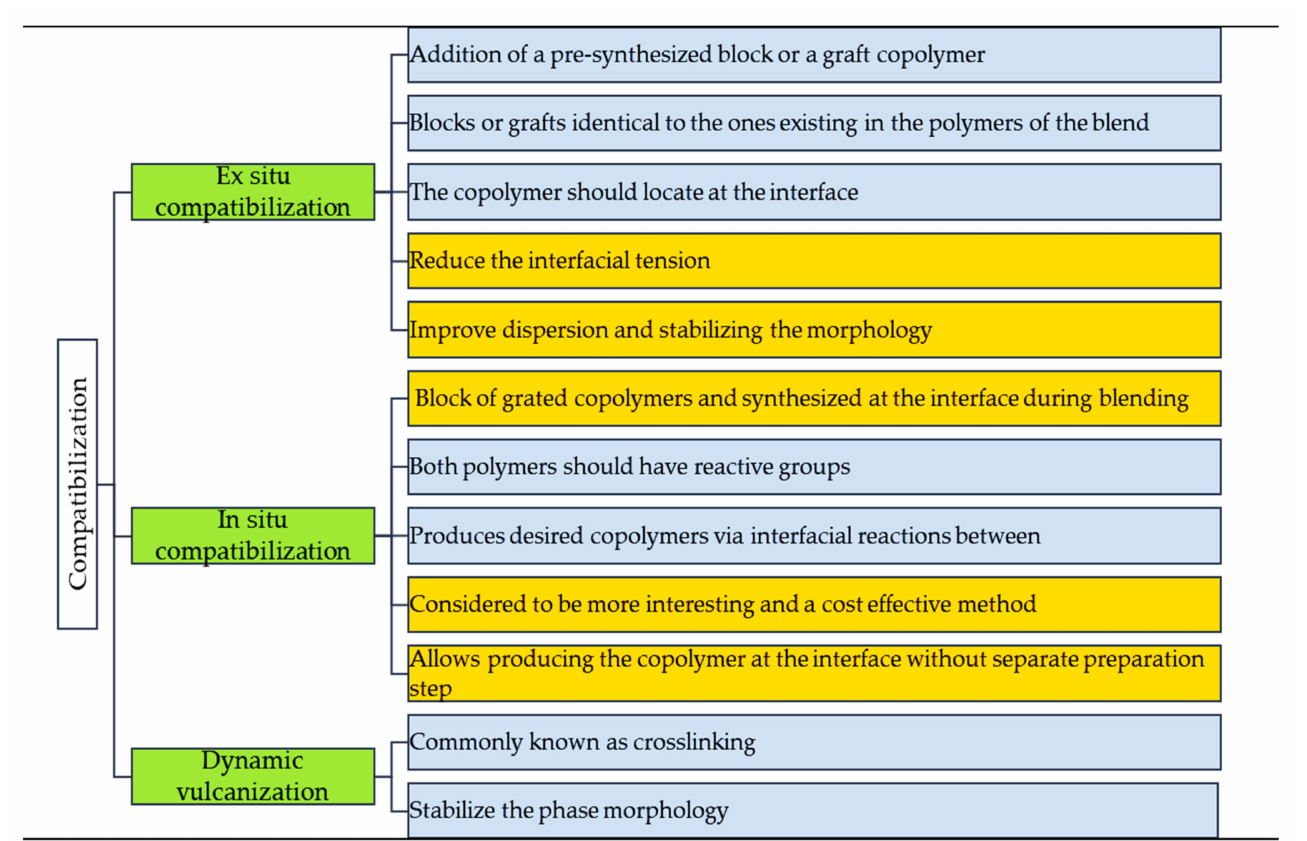
Figure 4. Summary of different types of